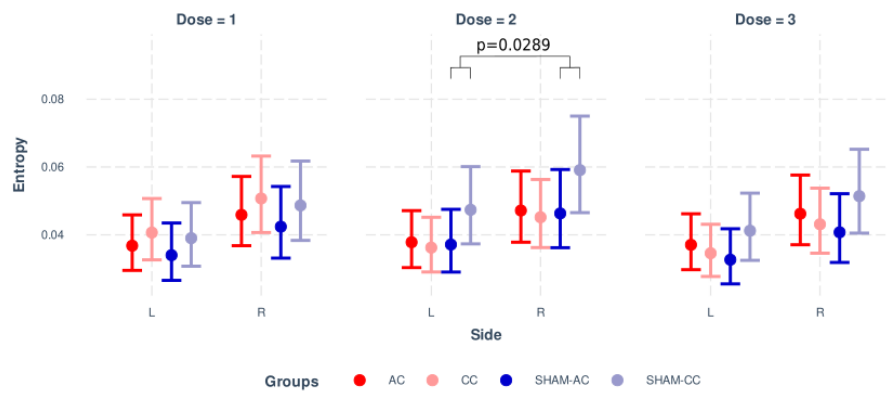
Figure 6. Comparison of the entropy measurements across the different brain stimulation conditions, and the interaction effects between categorical predictors from the adjusted GLMM [26]. The results indicate that our sham protocol would not yield effects in our variable of interest and that the cathode center condition induced a significant effect on the postural